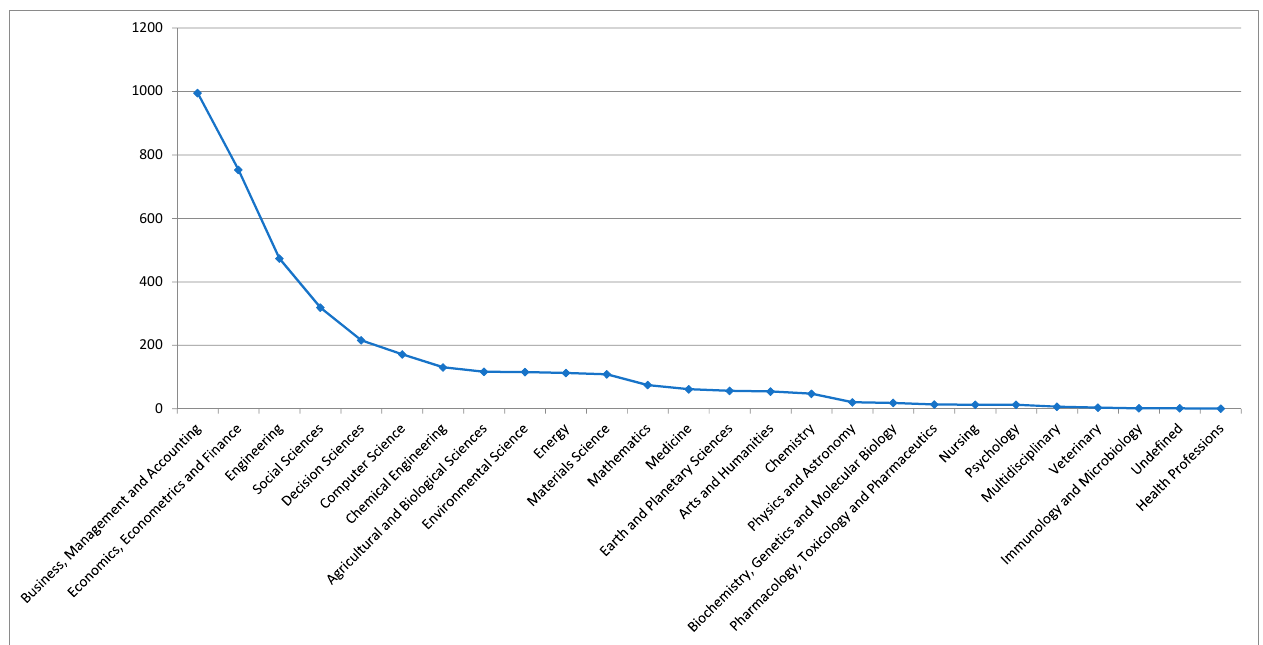
Figure 4. Distribution of records by subject area (Scopus).